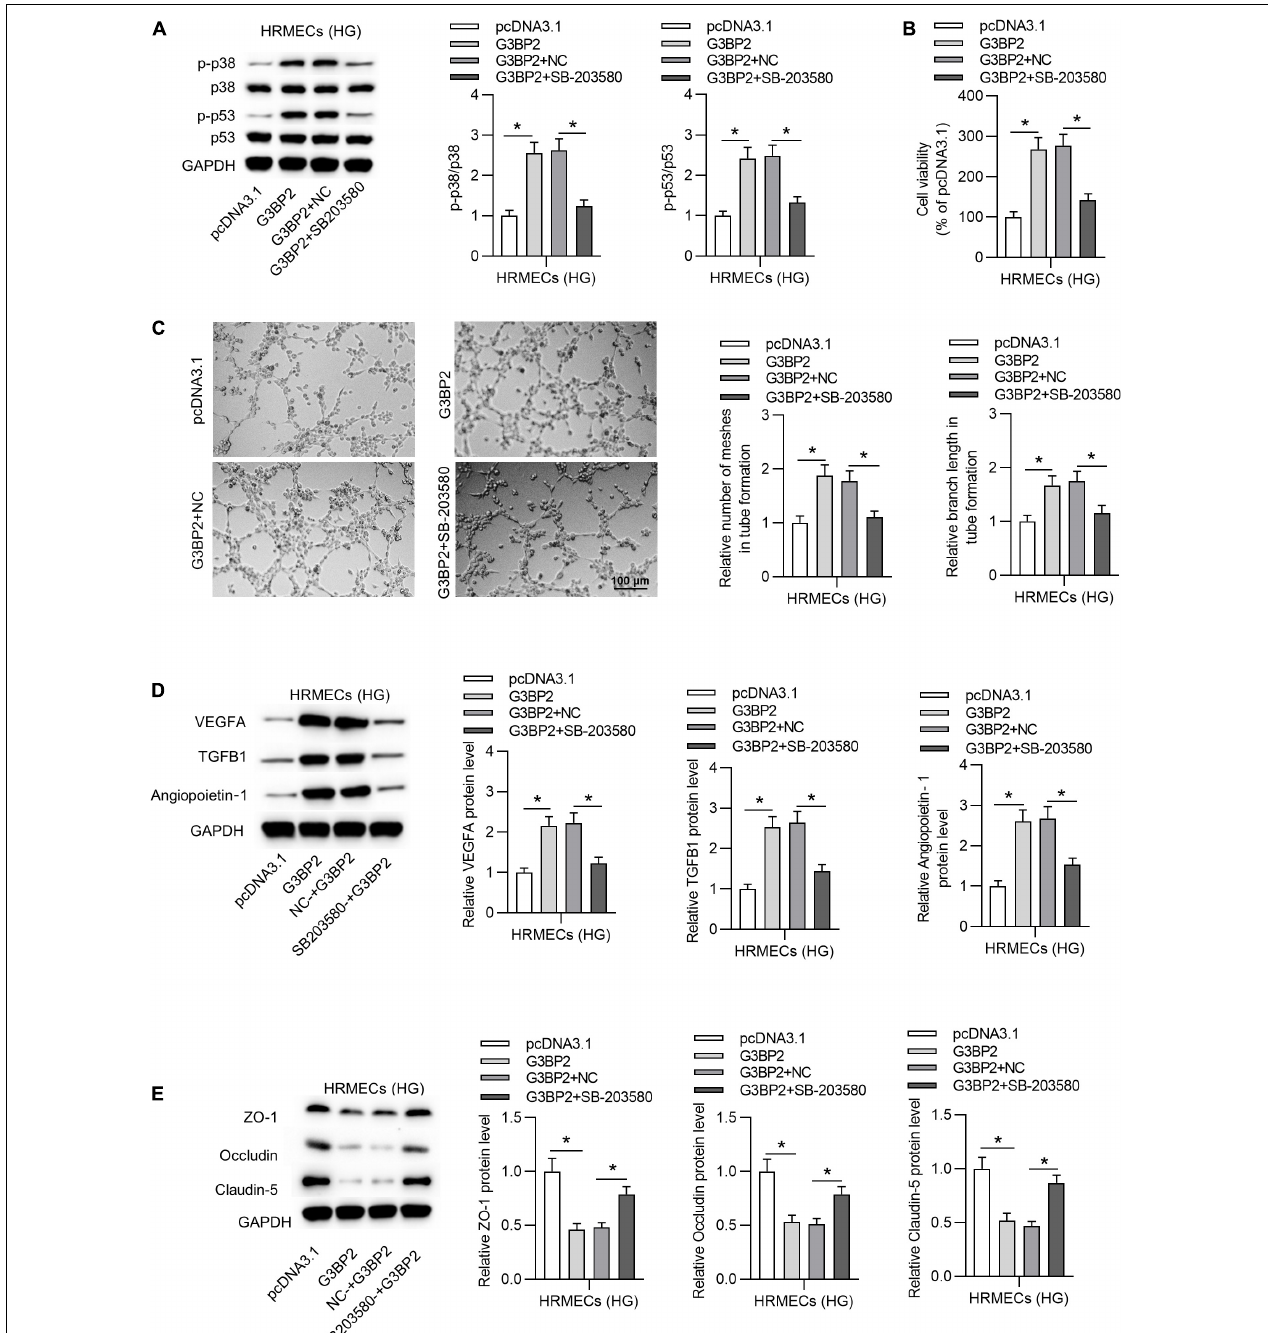
FIGURE 6 | MiR-124-3p promoted HG-induced injury of HRMECs through the p38MAPK signaling pathway. (A) The protein levels of p38, p53, phosphorylated p53 and p38 in HG (30 mM glucose)-stimulated HRMECs for 48 h followed by the transfection of pcDNA3.1/G3BP2, or cotreatment of pcDNA3.1/G3BP2 + SB203580 were analyzed by western blot analysis. (B) The viability of HG (30 mM glucose)-stimulated HRMECs followed by different treatments was evaluated by CCK-8 assay. (C) The mesh number and branch length of HG (30 mM glucose)-stimulated HRMECs after different treatments were detected by tube formation assay. (D) Western blot analysis measured the levels of proteins associated with angiogenesis (VEGFA, TGFB1 and Angiopoietin-1) in HG (30 mM glucose)-stimulated HRMECs in the four groups. (E) The levels of proteins associated with blood-ocular barrier (ZO-1, Occludin and Claudin-5) in HG (30 mM glucose)-stimulated HRMECs in different groups were analyzed by western blot analysis. * P <